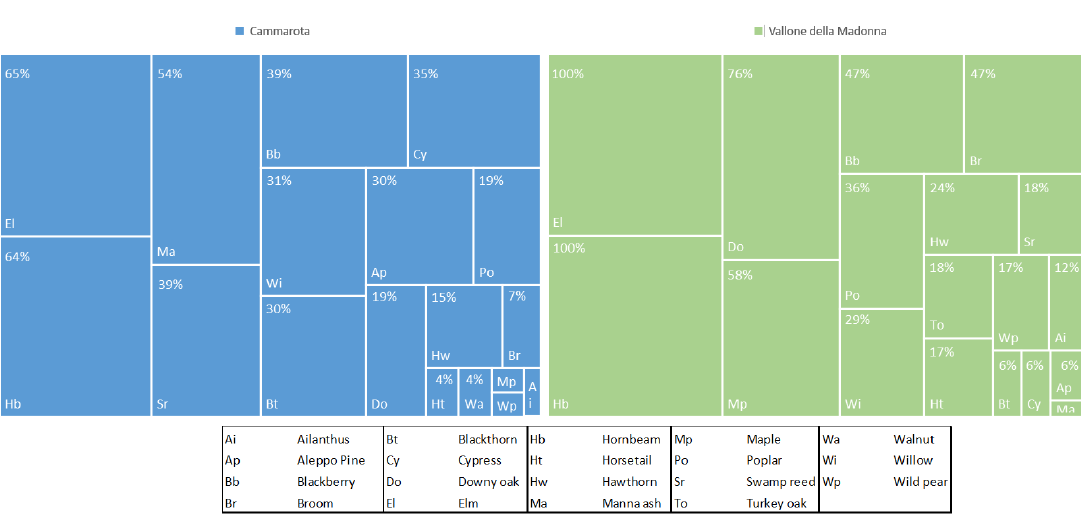
Figure 2. Distribution of vegetation species in the Cammarota Stream (CR) and in the reach of the Vallone della Madonna Stream (R5). The values not specified correspond to 2%.